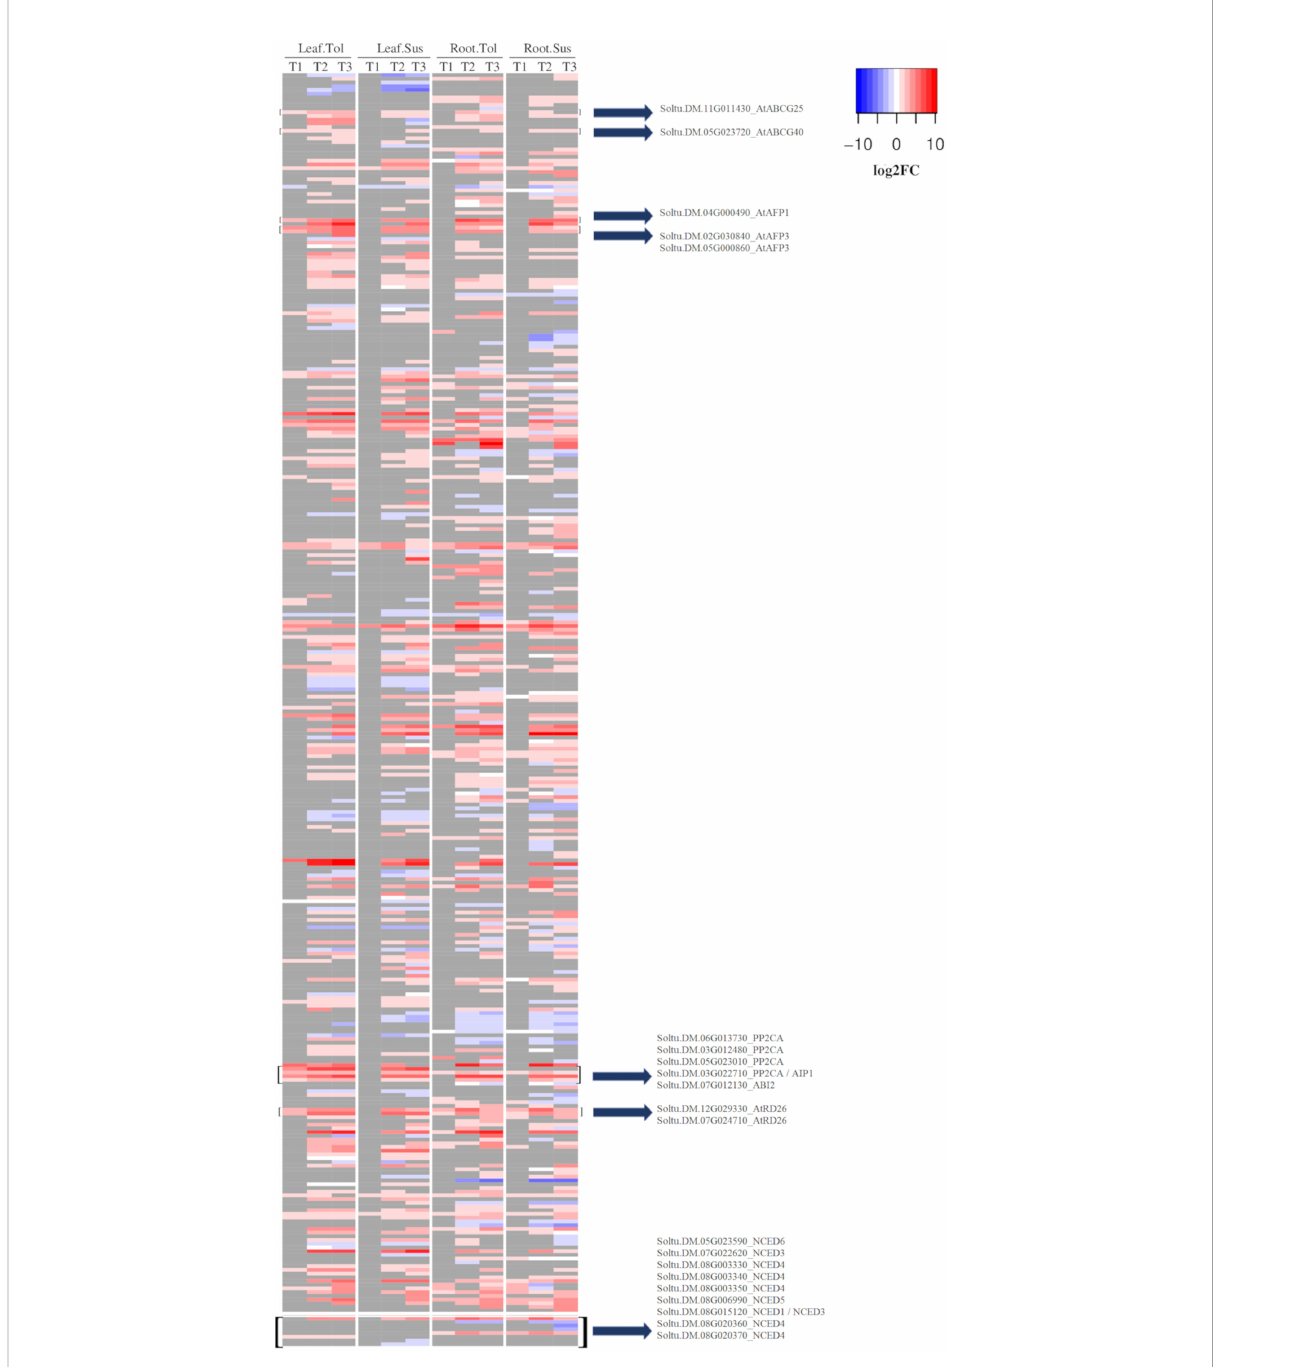
FIGURE 4 Heatmap of the log2 fold change for DEGs related to the ABA response. Shown is the log2FC compared to the non-stressed control for all DEGs annotated with GO:0009737 and all NCED genes. In grey are genes with no signi fi cant change in the respective time point (early T1, late T2, and recovery T3), tissue, or